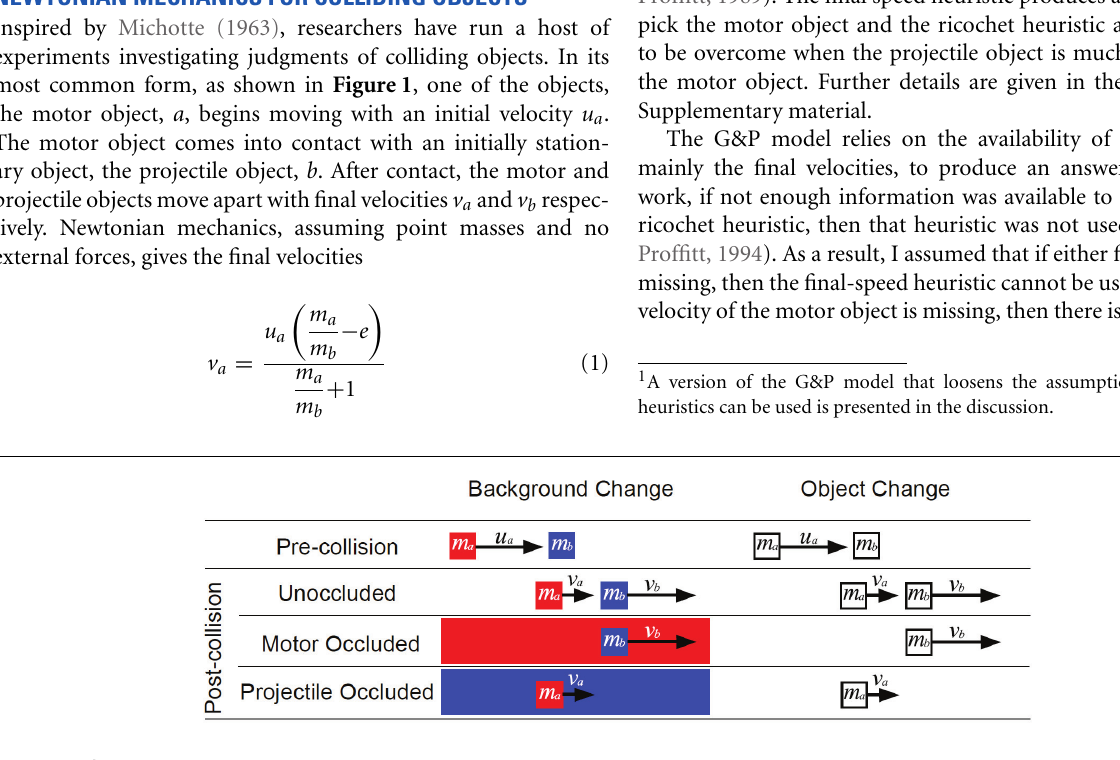
FIGURE 1 | Schematic of the trials shown in the experiment. The pre-collision event occurred in every trial with only the mass ratio and u a varying.Velocitiestotherightaredefinedaspositiveandtotheleftasnegative.